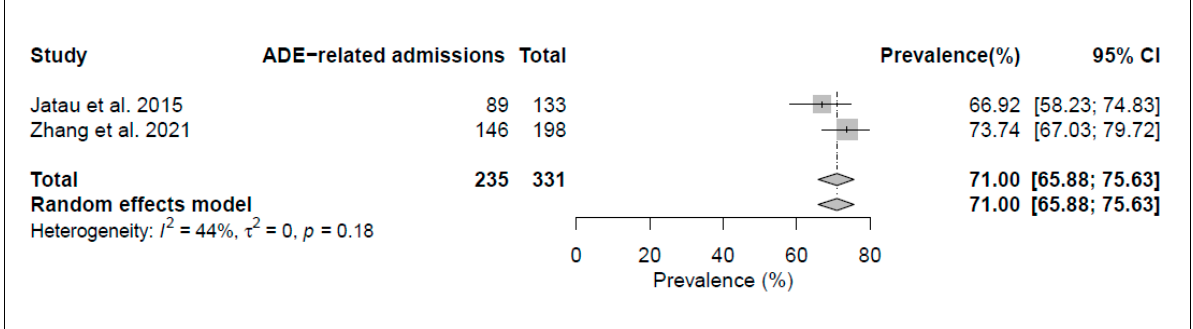
Figure 5. Forest plot of the pooled preventability rates of ADE-related ED visits/hospital admissions [39,40].